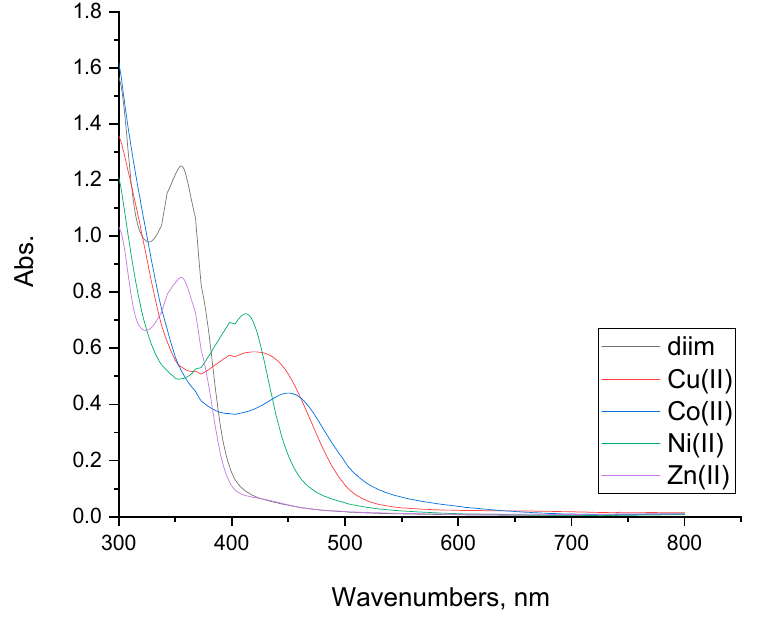
Figure 6. UV-Vis spectra of diim free ligand and its Co(II), Ni(II), Cu(III) and Zn(II) complexes.